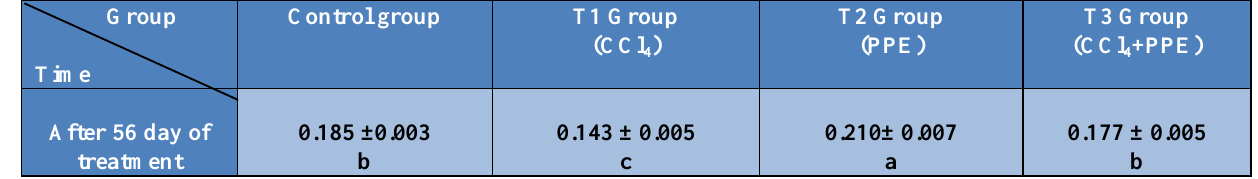
, (PPE) and (PPE+ CCl 4